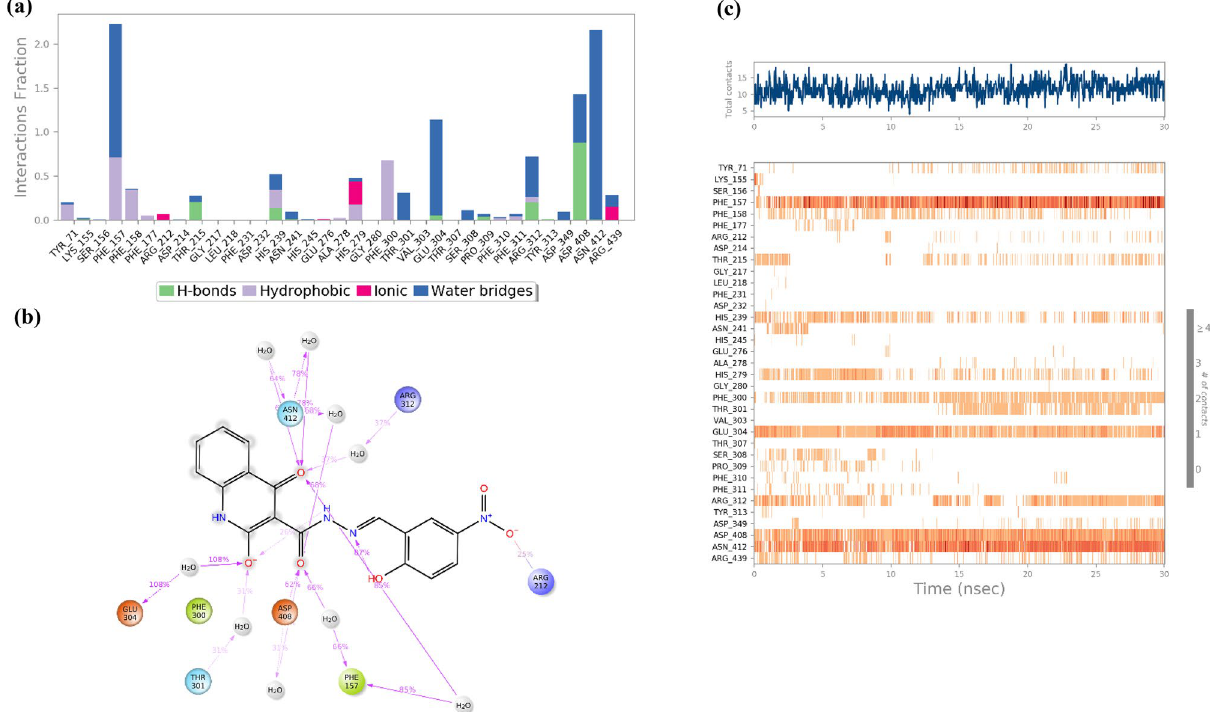
Figure 9. Type of interactions of compound 6m within α-glucosidase ( a ), 2D representation of ligand-residue interactions that occur at least 25% of simulation time at the equilibrated phase of MD simulation which include α-glucosidase bound-state with compound 6m ( b ) and timeline rendering of interacting residues during the whole simulation time ( c